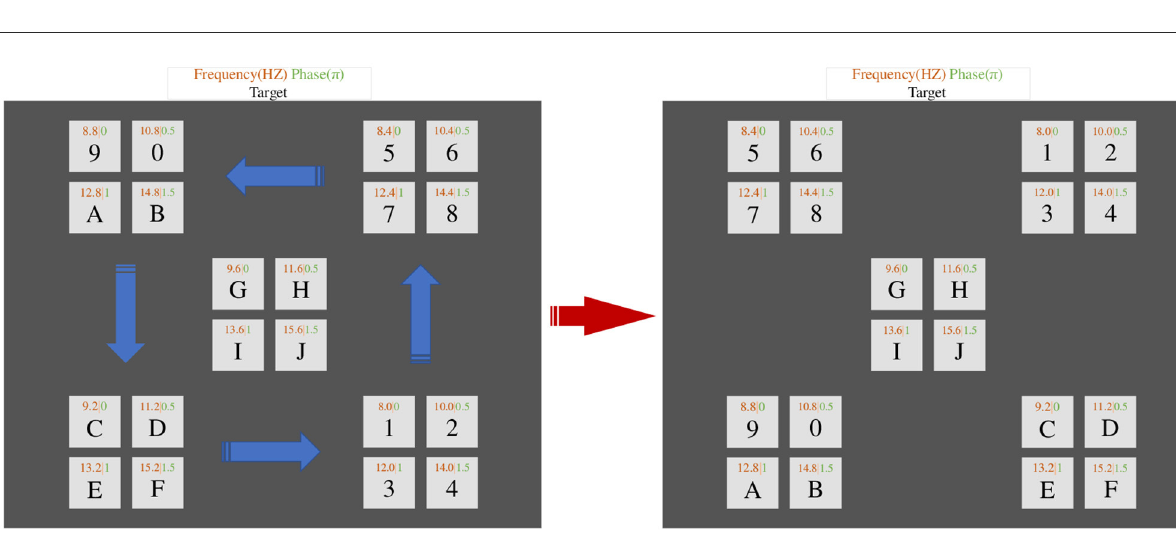
FIGURE2 Schematic diagram of the button and changes layout displayed on the GUI. The blue arrows indicate the direction of movement of the regions, and the frequency and initial phase of each target flicker used for SSVEP are also shown in the diagram. The frequency interval in the same region is 2 Hz and the phase interval is 0.5 π